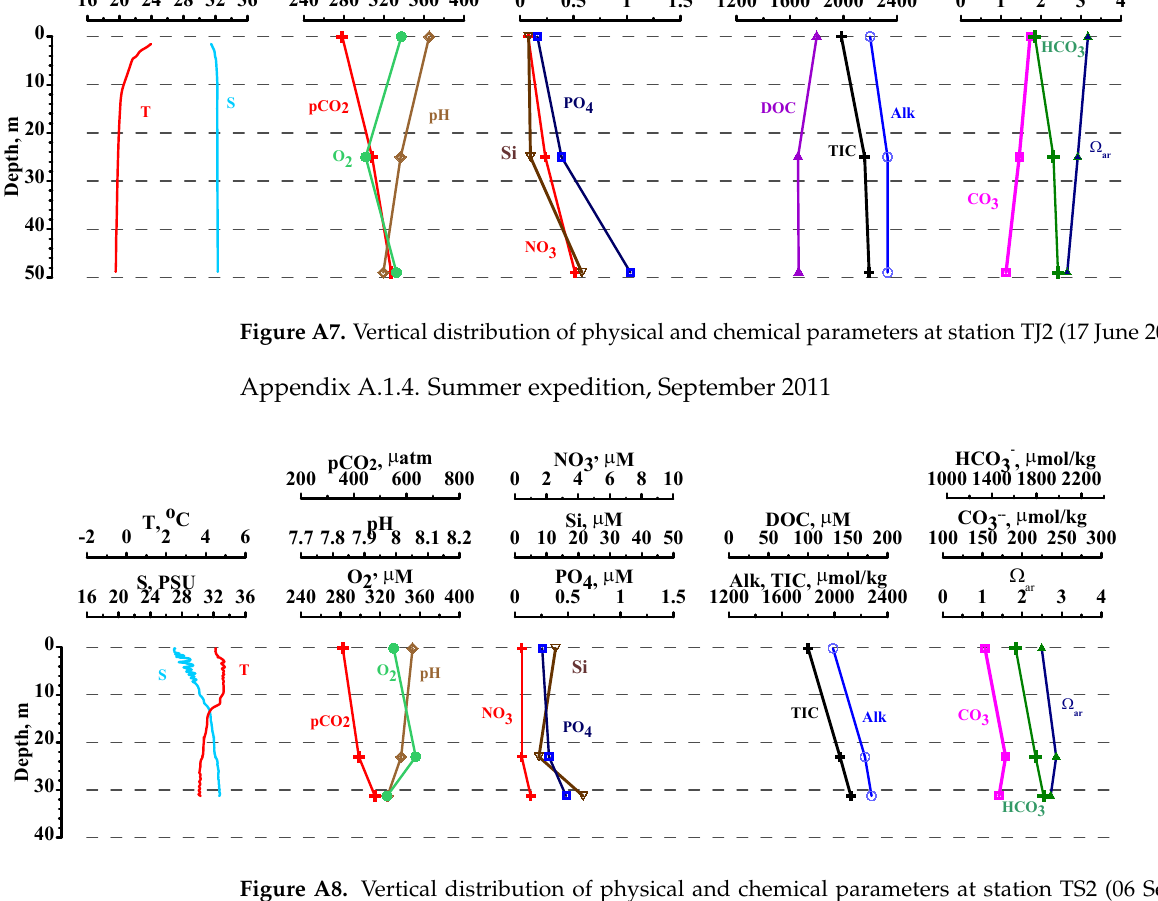
Figure A8. Vertical distribution of physical and chemical parameters at station TS2 (06 September 2011).